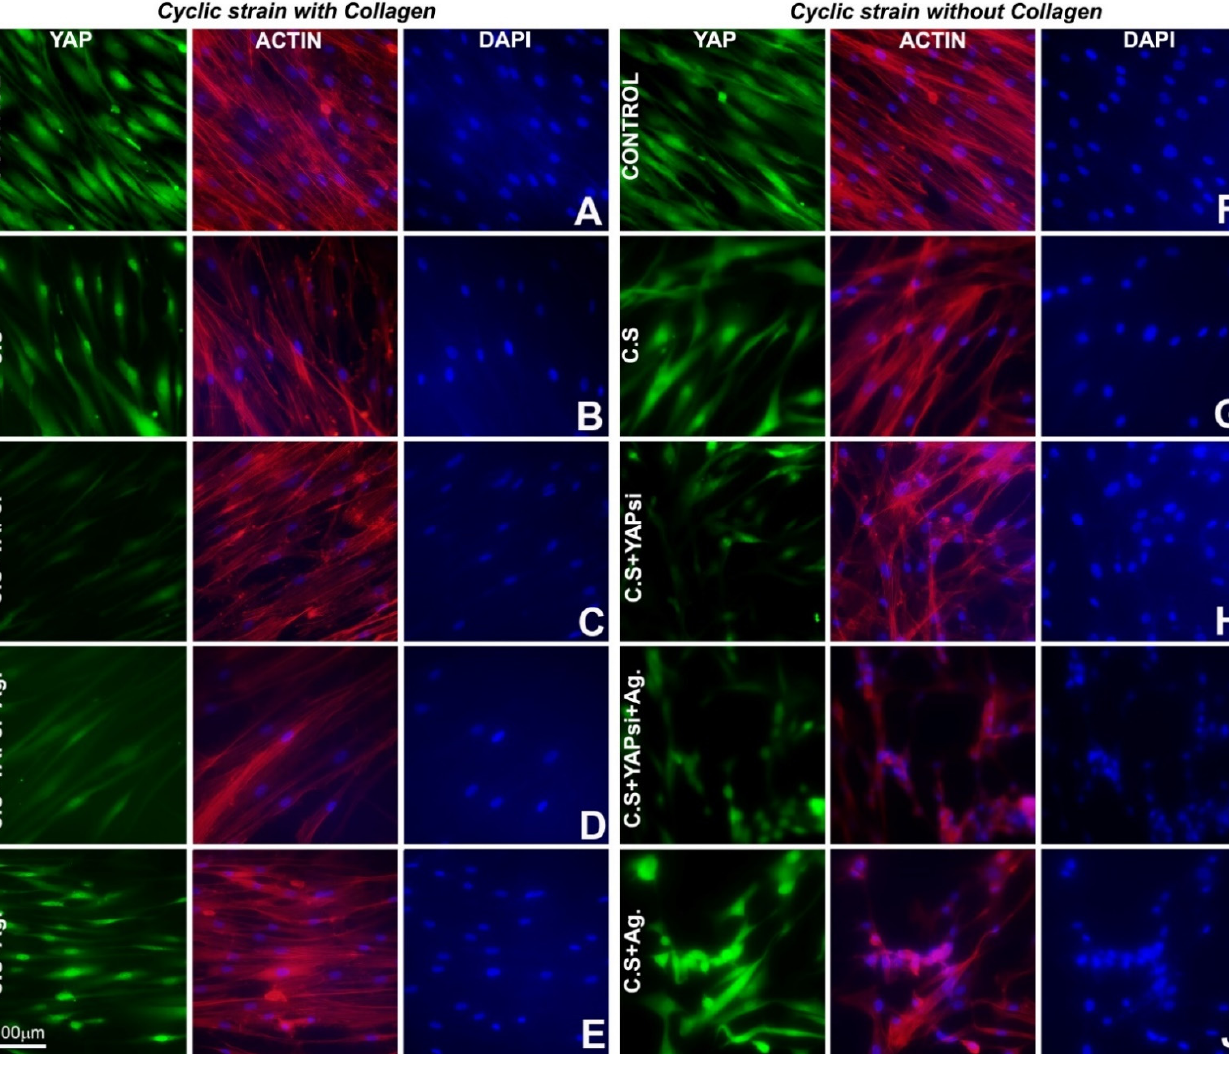
Figure 2. YAP1 localization and cytoskeletal staining during cyclic strain in PDL cells. ( A – J ) Repre- sentative immunofluorescence images for YAP1 localization and actin distribution following cyclic mechanical strain on PDL cells grown on collagen-coated plates ( B – E ) and without collagen ( G – J ) under indicated treatment conditions. ( A , F ) PDL cells grown with or without collagen and not sub- jected to any mechanical cyclic strain served as controls. Actin was detected using Alexa Fluor 594 Phalloidin (Red) and is presented in a merged form together with cell nuclei counterstained with DAPI (blue). YAP1 was detected using Alexa Fluor 488 (green). Note the distinctive nuclear locali- zation for YAP1 upon cyclic strain in PDL cells grow on collagen-coated surface ( B ) and to a lesser extent in cells without collagen ( G ).